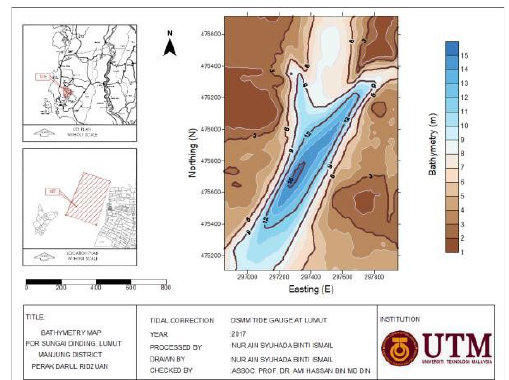
Figure 15. Bathymetric plan relative to the DSMM tide gauge in 2017 generated using Surfer